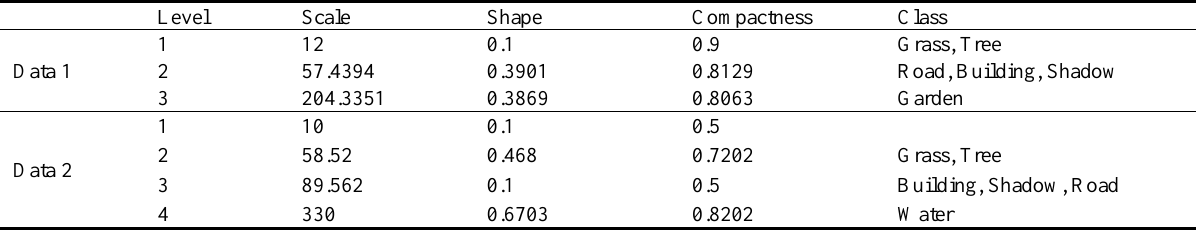
Table 4. Multiresolution segmentation parameters for the two